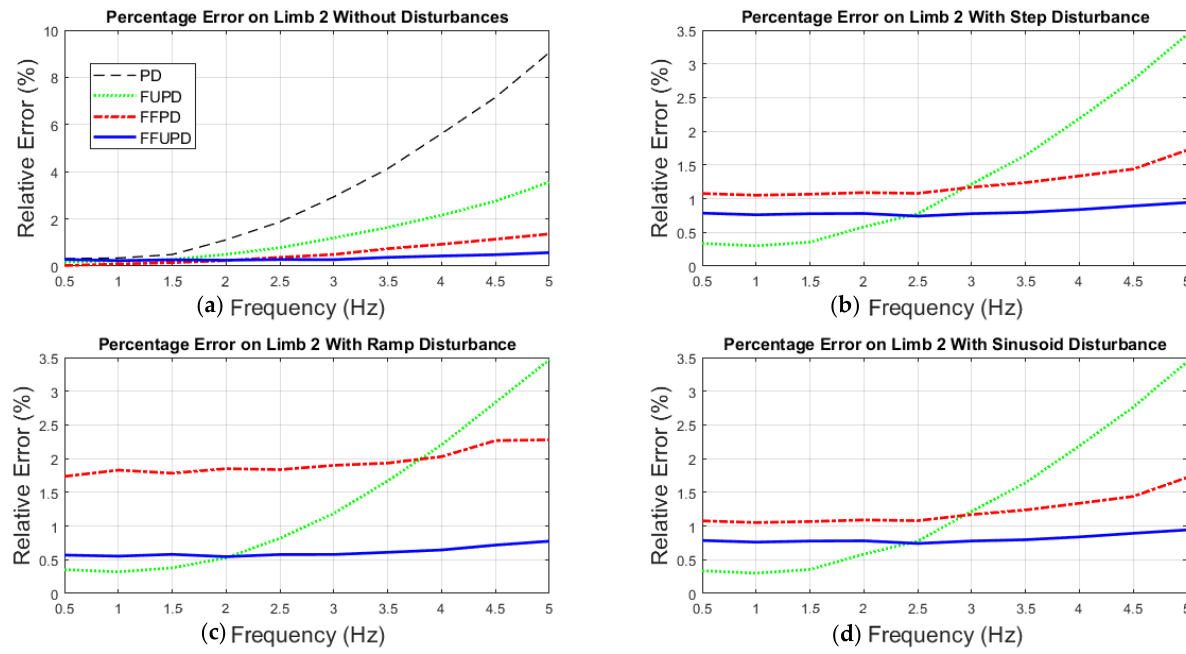
Figure 17. Percentage error in limb 2 when following desired trajectories at different flapping frequencies. Different control strategies employed to reduce error in the absence of external disturbances ( a ), or in the presence of ( b ) step, ( c ) ramp or ( d ) sinusoid disturbances.